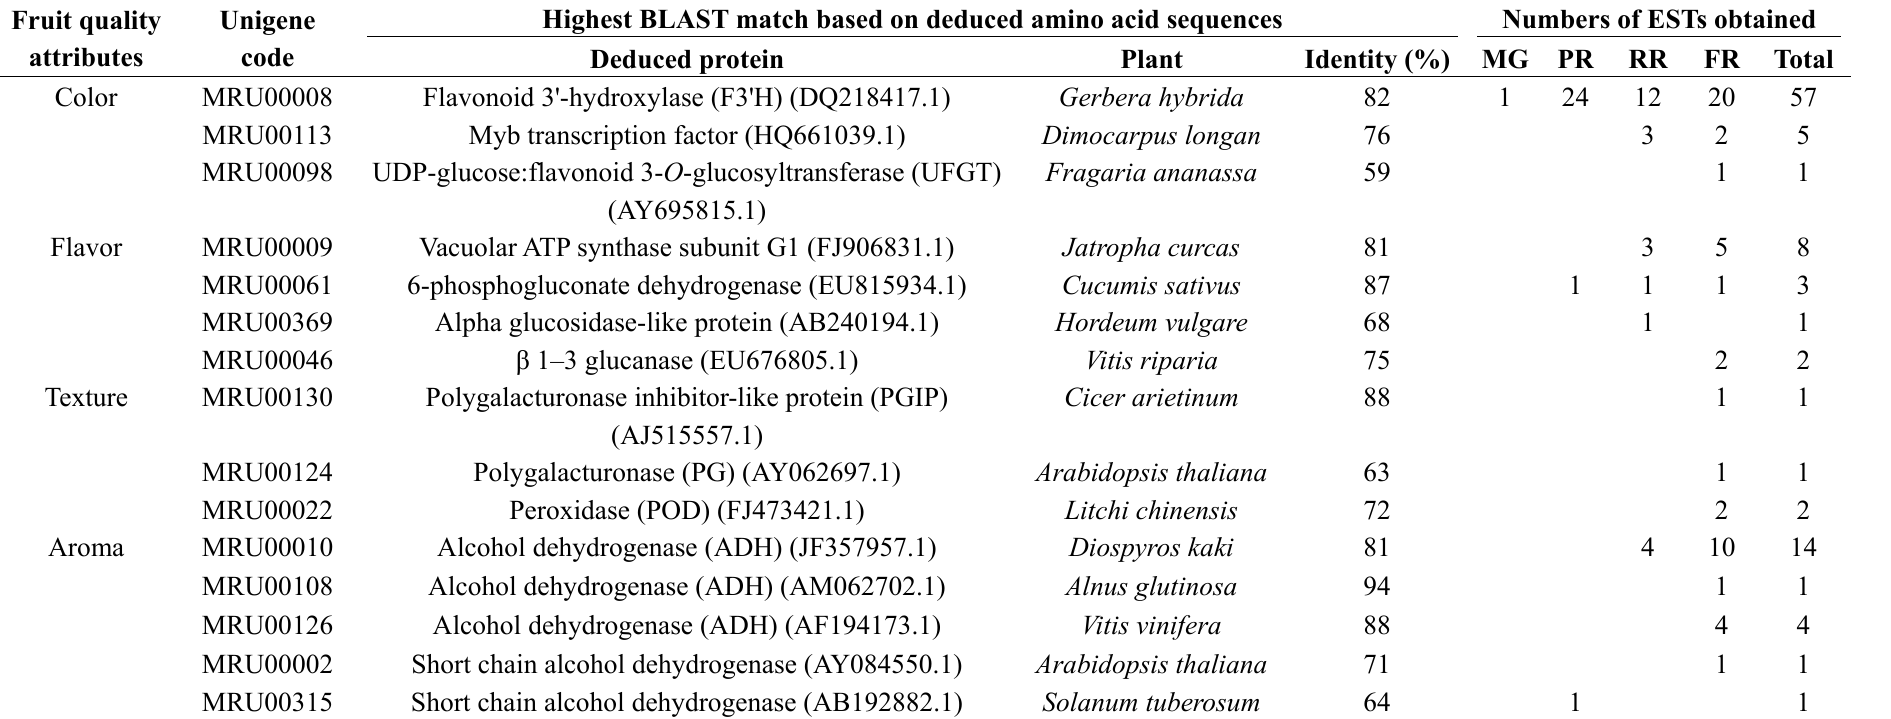
Table 5. Identification of genes associated with quality formation during fruit ripening from “Biqi” fruit